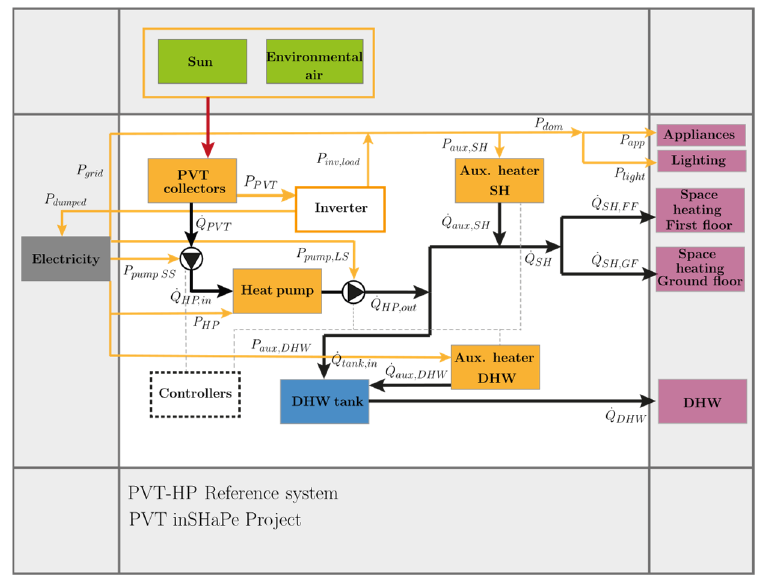
Figure 7. Control schematic of the two-stage room thermostats.